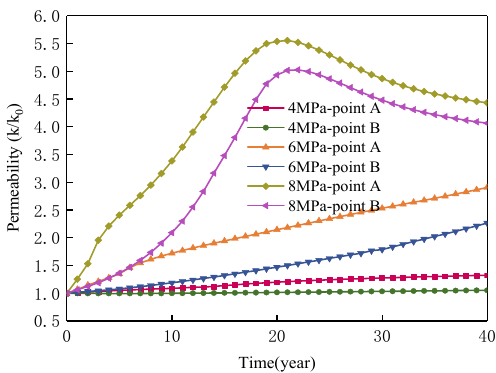
Figure 9. Permeability ratios of monitoring points at di ff erent injection